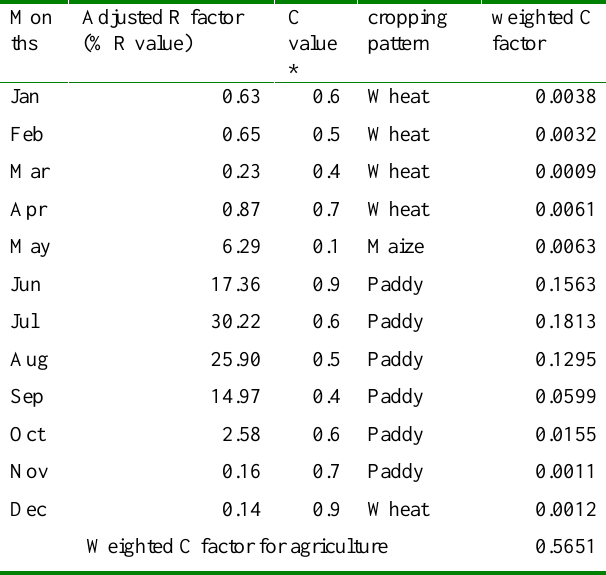
Table 3.Spatial extent of potential and actual soil loss estimation